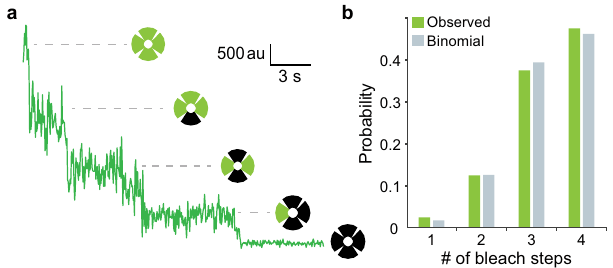
Fig. 3 Number of GFP-TAX-4 subunits per vesicle assessed by photobleaching of GFP. a Stepwise photobleaching of GFP fl uorescence in arbitrary units (au) from a single diffraction-limited spot. b The number of observed bleach steps for colocalized spots included in the analysis. The good fi t to a binomial distribution with four sites suggests that most spots contain a single tetrameric channel where bleaching of each GFP is observed with a probability of 0.82 and 95% CI [0.74, 0.89]. Source data are provided as a Source Data fi